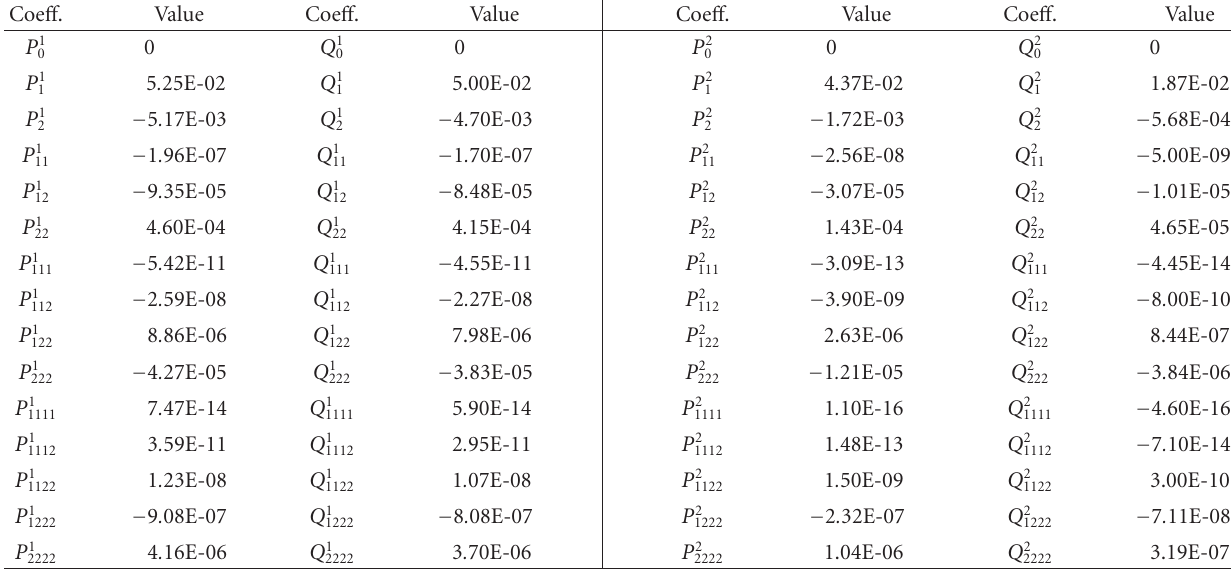
Table 2: Computed values for the Taylors series coe ffi